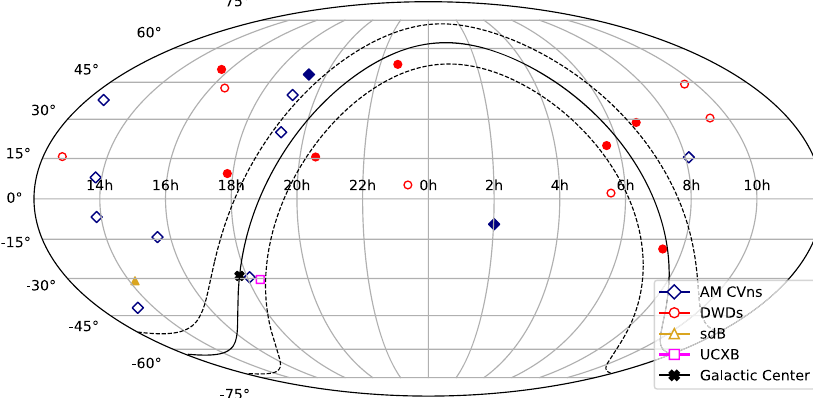
Fig. 3 Sky position of the veri fi cation binaries. The sky positions show a clear bias towards the northern hemisphere and to higher Galactic latitudes. The black line indicates the Galactic equator and j b j ¼ 10deg, with the Galactic Centre located at the black cross. See caption in Fig. 2 for explanation of acronyms. Image credit: Thomas